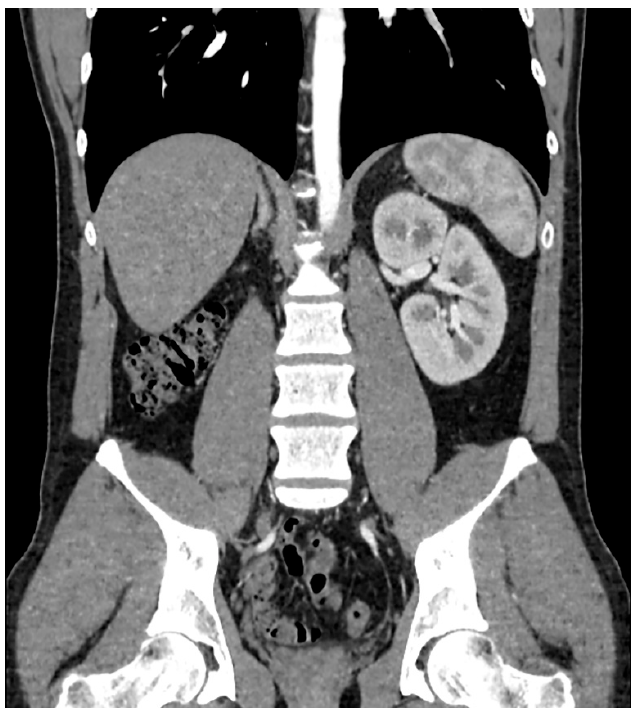
Figure 1. CT scan with contrast showing left kidney and absence of right kidney.